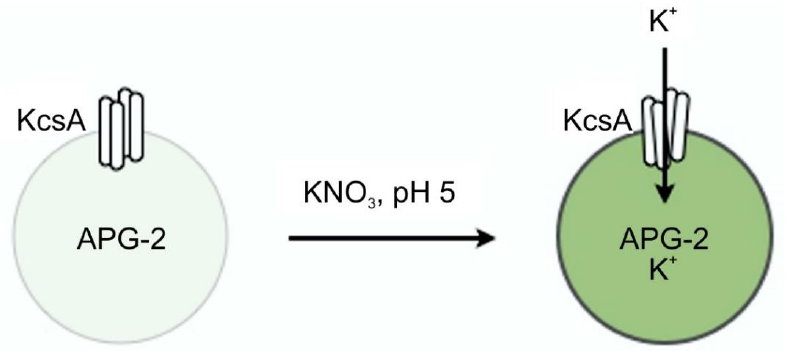
Figure 14. Principle of the liposome flux assay. Potassium ions transported through the KcsA channel open at pH 5.5 cause the dye APG-2 enclosed in the liposome to fluoresce at 540 nm upon excitation with 488